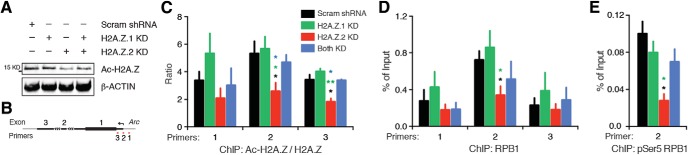
H2A.Z.2 facilitates priming of the Arc promoter. A, Representative Western blotting of whole-cell lysate showing Ac-H2A.Z levels in neurons depleted of H2A.Z hypervariants as indicated. N = 3. B, Graphical map (not to scale) depicting relative position of ChIP primers near Arc TSS. C, Quantification of Ac-H2A.Z (normalized by total H2A.Z) binding to Arc TSS region in neurons treated as indicated, determined by ChIP. N = 4. Two sets of data in statistical comparison are represented by the position and the color of asterisk(s). D, ChIP data demonstrating binding of RPB1 to the Arc TSS region in control neurons or H2A.Z hypervariant-depleted neurons as indicated. N = 4. Note the enrichment of RPB1 at the TSS (primer 2) in control neurons (black) indicating promoter-proximal RNA Pol II pausing. E, ChIP data demonstrating binding of pSer5-RPB1 to the Arc TSS in control and hypervariant-depleted neurons. N = 3. *p < 0.05 and **p < 0.01.